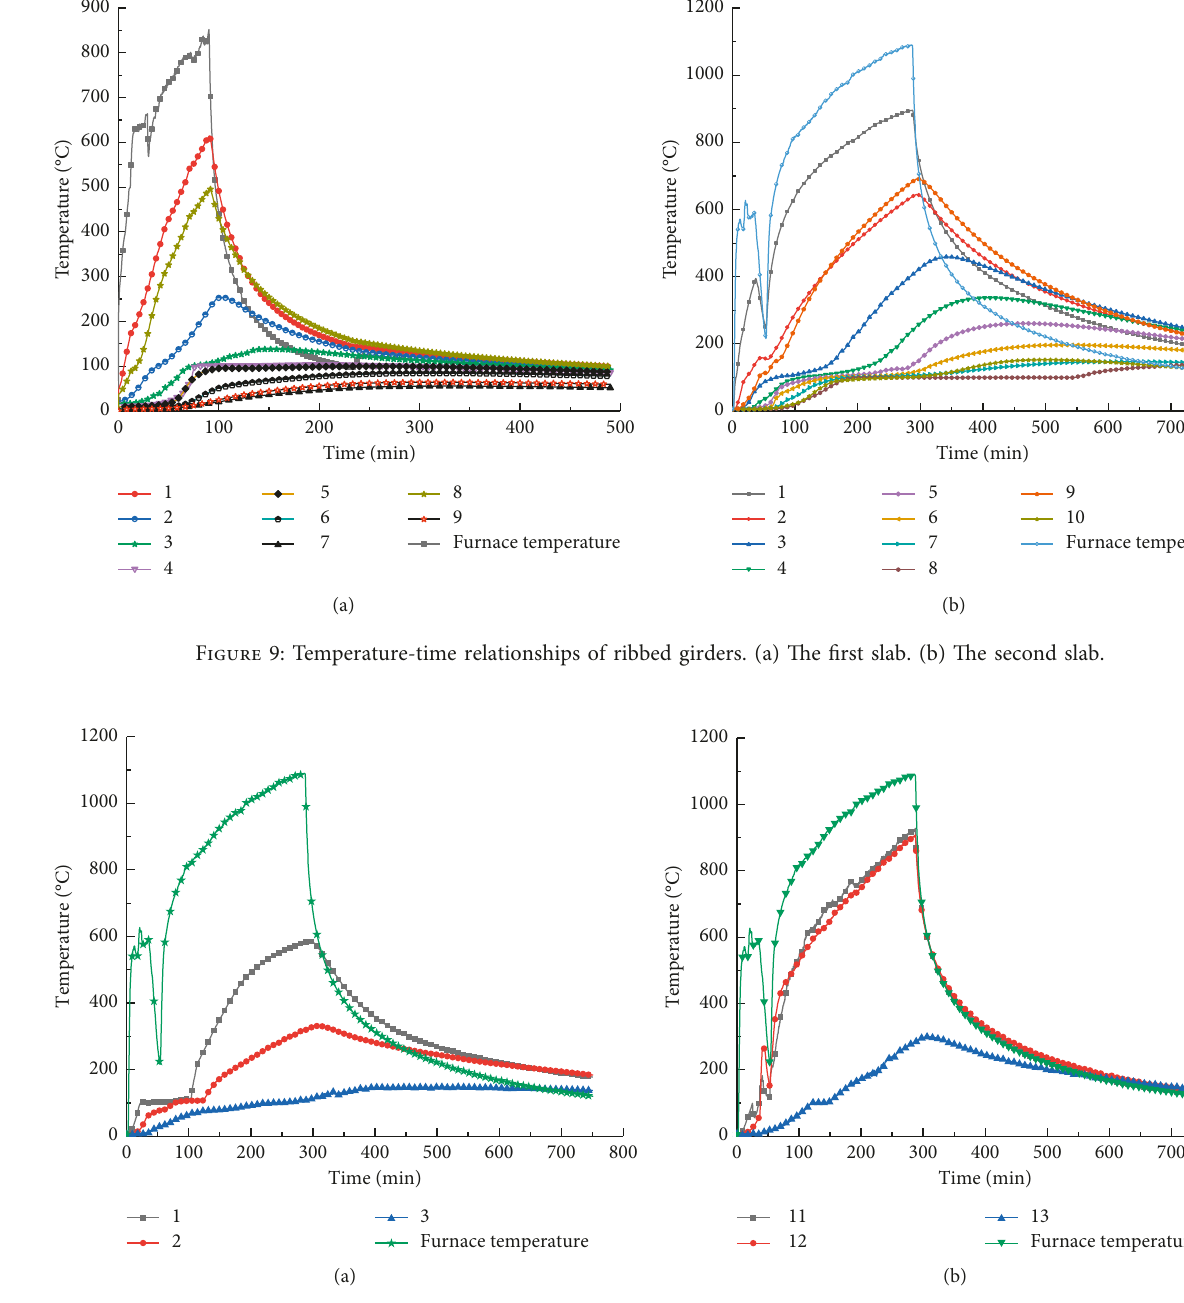
Figure 10: Temperature-time relationships of the covered boxes. (a) Without burn through. (b) Burn through.